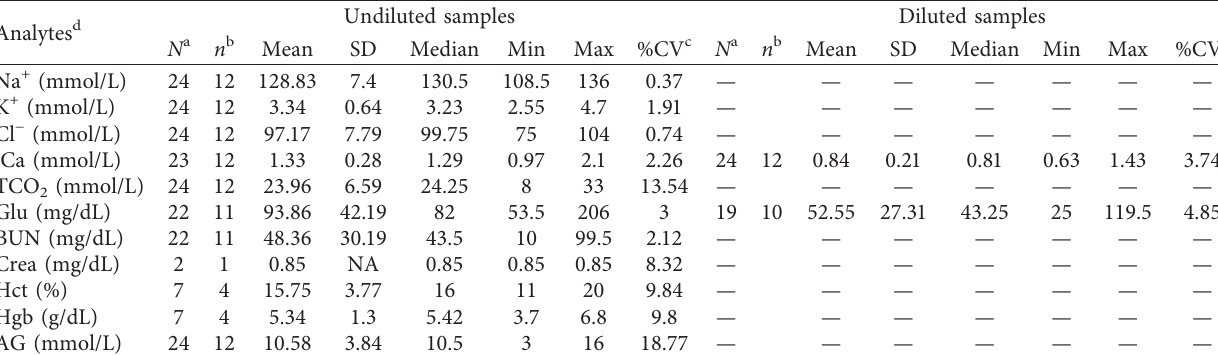
Table 1: Biochemistry results from heparinized undiluted and heparinized dilute blood samples from 12 eastern box turtles ( Terrapene carolina carolina ) using an i-STAT portable analyzer.